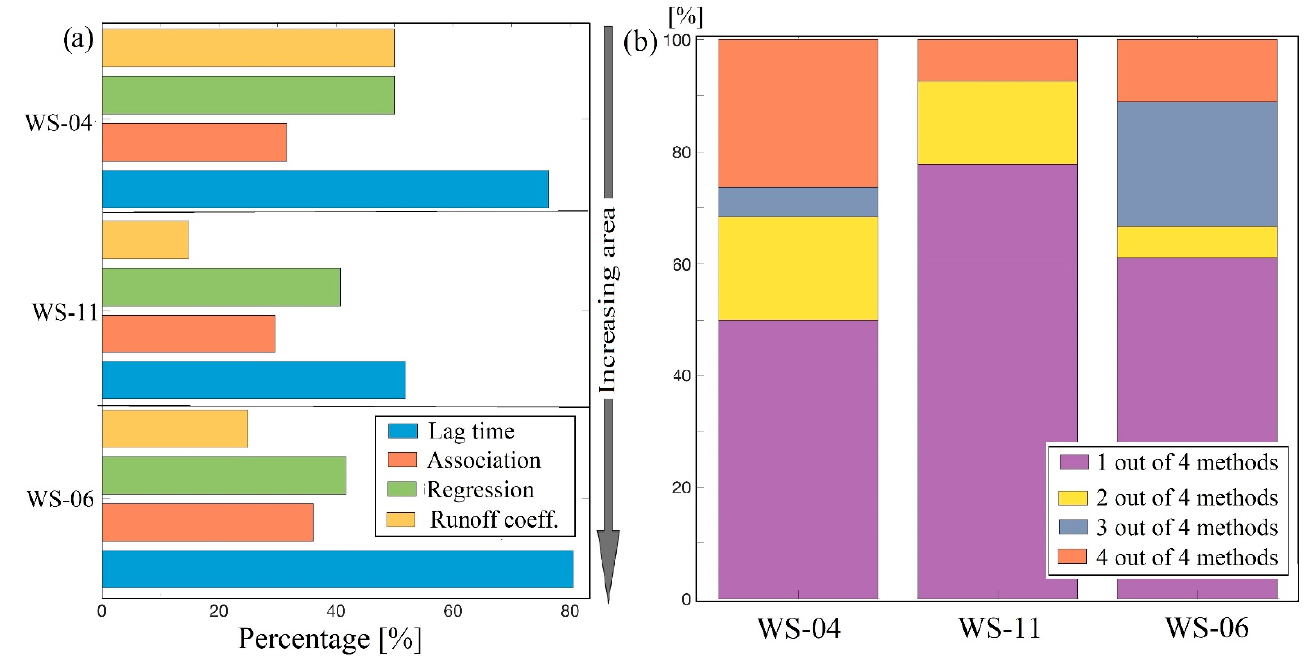
Figure 7. ( a ) Percentage of events flagged by the four of the five methods for the three sub-water- sheds, ( b ) Percentage of the total number of flagged events identified by one to four methods sim- ultaneously.